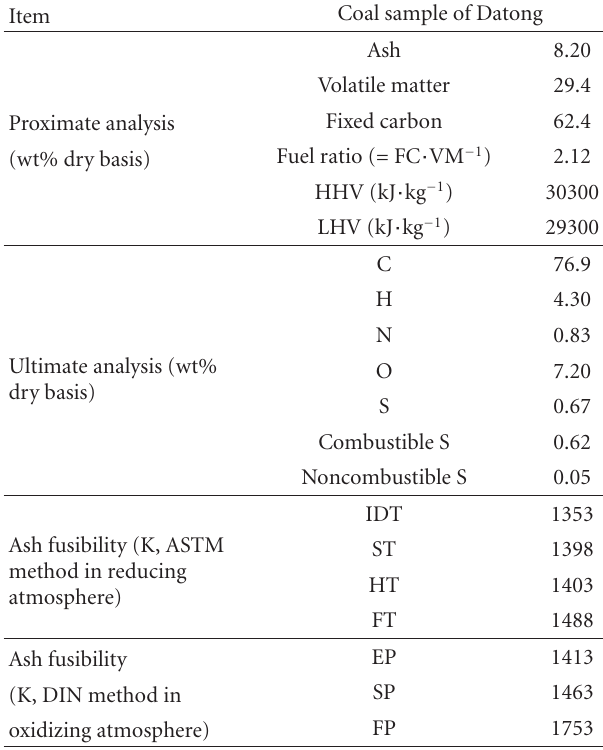
Table 1: The properties of coal